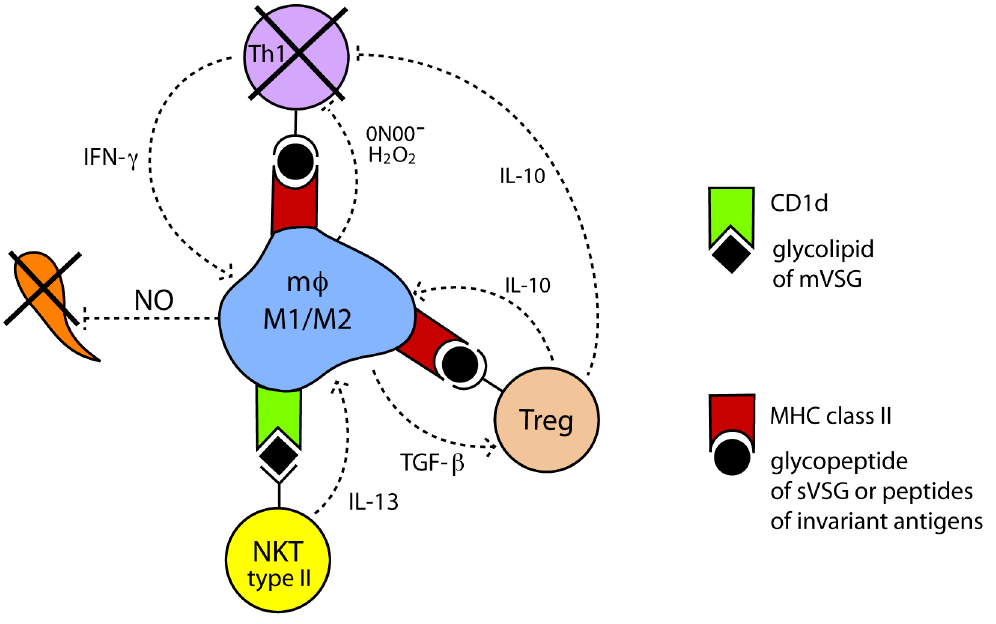
Figure 2. Minimal model: immunosuppression at primary intradermal infections by low numbers of trypanosomes. Macrophages that have engulfed filopodia of trypanosomes [33] or whole killed trypanosomes will process trypanosome antigens and present them at their cell surface. Glycosylphosphatidylinositol (GPI) of membrane variant surface glycoprotein (mVSG) will be presented via CD1d to NKT cells [9,17]. We argue that the NKT cells are predominantly type II NKT cells that release IL-13 which, in turn, skews the macrophages toward the M2 type. Thus, the antigen- presenting macrophages will predominantly be a mixed M1/M2 type (see text). MHC class II will present peptides to MHC class II–restricted T cells. The microenvironment will skew the naı¨ve MHC class II–restricted T cells towards Tregs [3,15], presumably via TGF- b produced by macrophages. Tregs, in turn, activate the Arg1 pathway of macrophages by production of IL-10. We propose that many of the naı¨ve trypanosome-specific T cells that develop into Th1 effector cells are deleted by apoptosis, due to peroxynitrite (ONOO-) produced by macrophages under conditions of shortage of L-arginine supply [25], or are functionally impaired by down-regulation of CD3zeta [34].